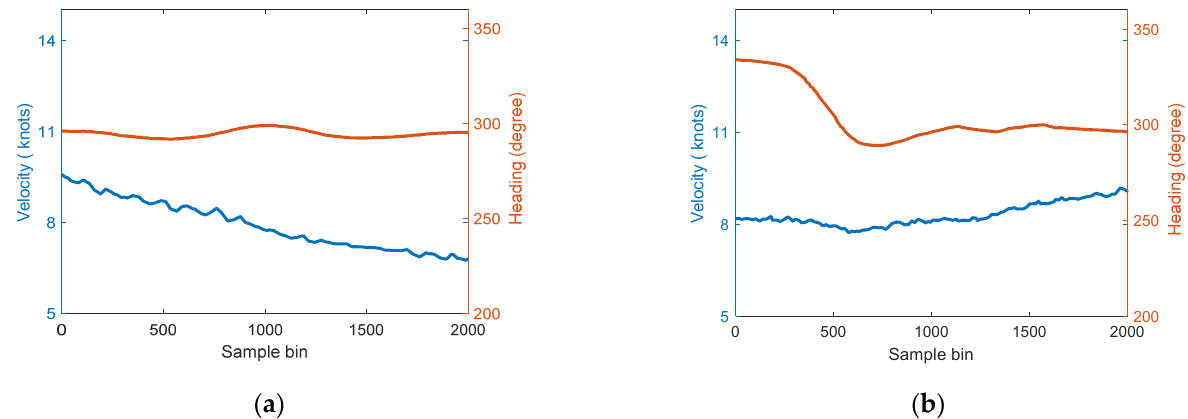
Figure 26. The variation of the ship velocity and heading: ( a ) during P1, ( b ) during P2. During the time period P1, the ship heading remains relatively stable while the velocity target T1 is 35km (its mmsi = 414,400,020) from the radar station, and the angle of the line from the ship target to the shipborne platform is 344 ◦ with respect to north. Figure 27